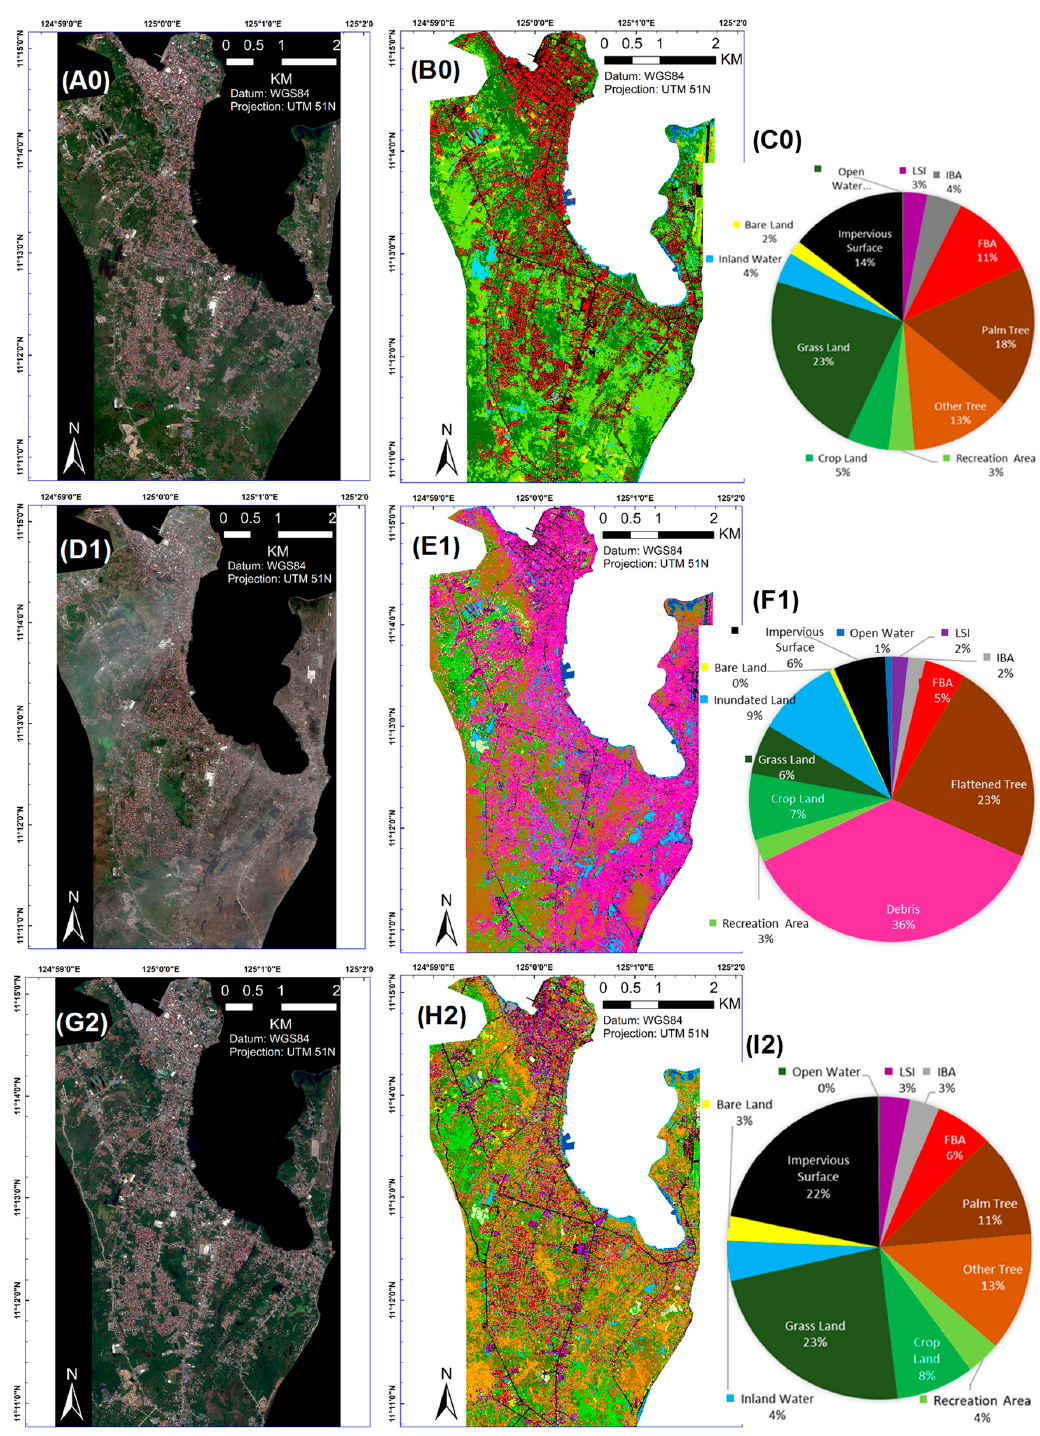
Figure 9. ( A0 , D1 , G2 ): WorldView-2 images acquired over Tacloban city from 8 months before, right Figure 9. ( A0 ), ( D1 ), ( G2 ): WorldView-2 images acquired over Tacloban city from 8 months before, after, and 4 years after Typhoon Haiyan, respectively; ( B0 , E1 , H2 ): LU classification maps from SVM right after, and 4 years after Typhoon Haiyan, respectively; ( B0 ), ( E1 ), ( H2 ): LU classification maps relying on LBP features and NDVI2 for the three-time epoch; ( C0 , F1 , I2 ): Corresponding pie charts from SVM relying on LBP features and NDVI2 for the three-time epoch; ( C0 ), ( F1 ), ( I2 ): show class distribution of LU classes in Tacloban city. LSI: Large scale industry; IBA: Informal built up Corresponding pie charts show class distribution of LU classes in Tacloban city. LSI: Large scale area; FBA: Formal built up industry; IBA: Informal built up area; FBA: Formal built up area.